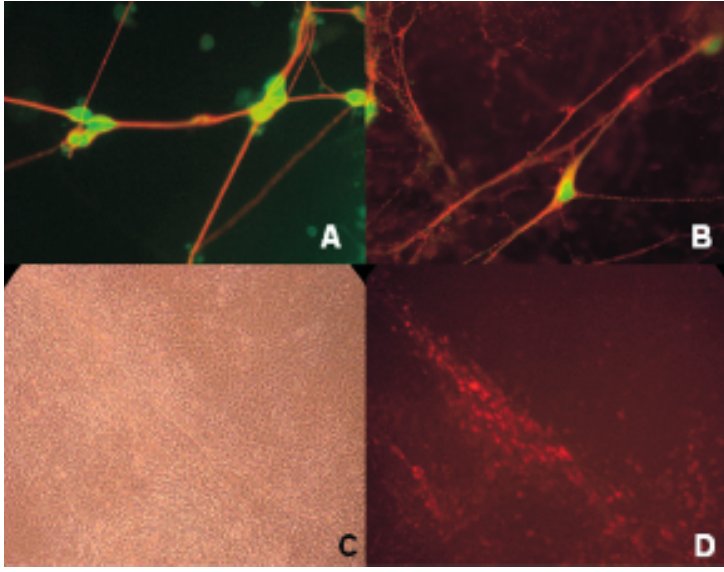
A and B: Neurons are identified by a b III-tubu- lin staining (in red). The degree of maturity of neurons can be identified using either the T a 1- a tubulin promoter to reveal young neurons (in green in A) or the Synapsin1 promoter to reveal mature neurons (in green in B). This approach can also be used to follow the emer- gence of neurons in a heterogenous ES-cell derived progeny. For this purpose, mouse ES cells were genetically modified to express a Red Fluorescent Protein (RedFP) driven by the T a 1- a tubulin promoter. C: Aggregate of ES cells in which newly formed neurons (red spots) can be identified by fluorescence microscopy